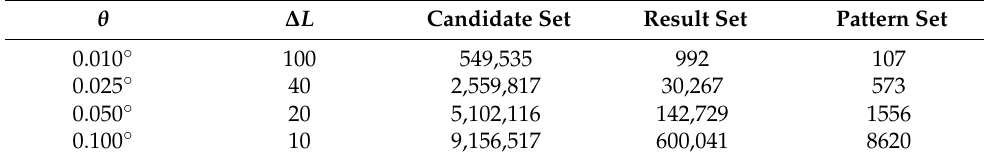
Table 5. Parameter setting and experimental results of the comparison experiment.